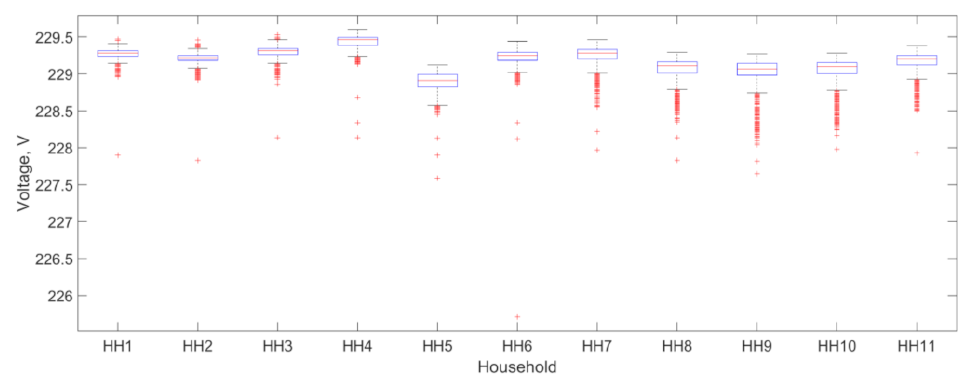
Figure 14. Box and whisker plot of the system voltage in the Gilutongan Island solar microgrid as measured in each of the households during the months of October and November 2020.